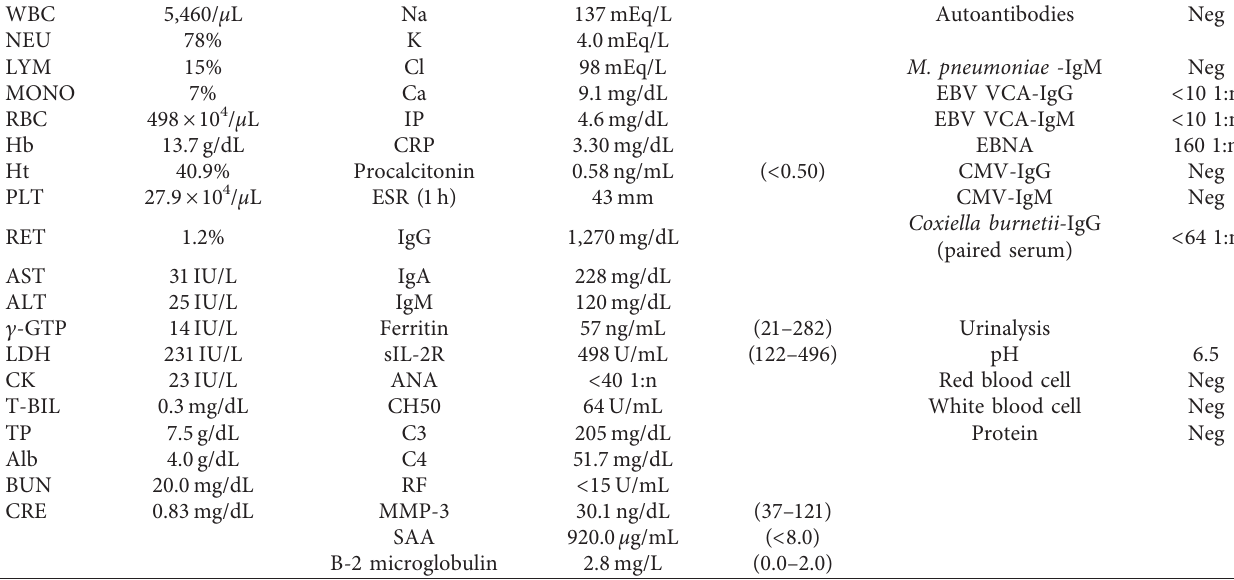
Table 1: Laboratory findings on